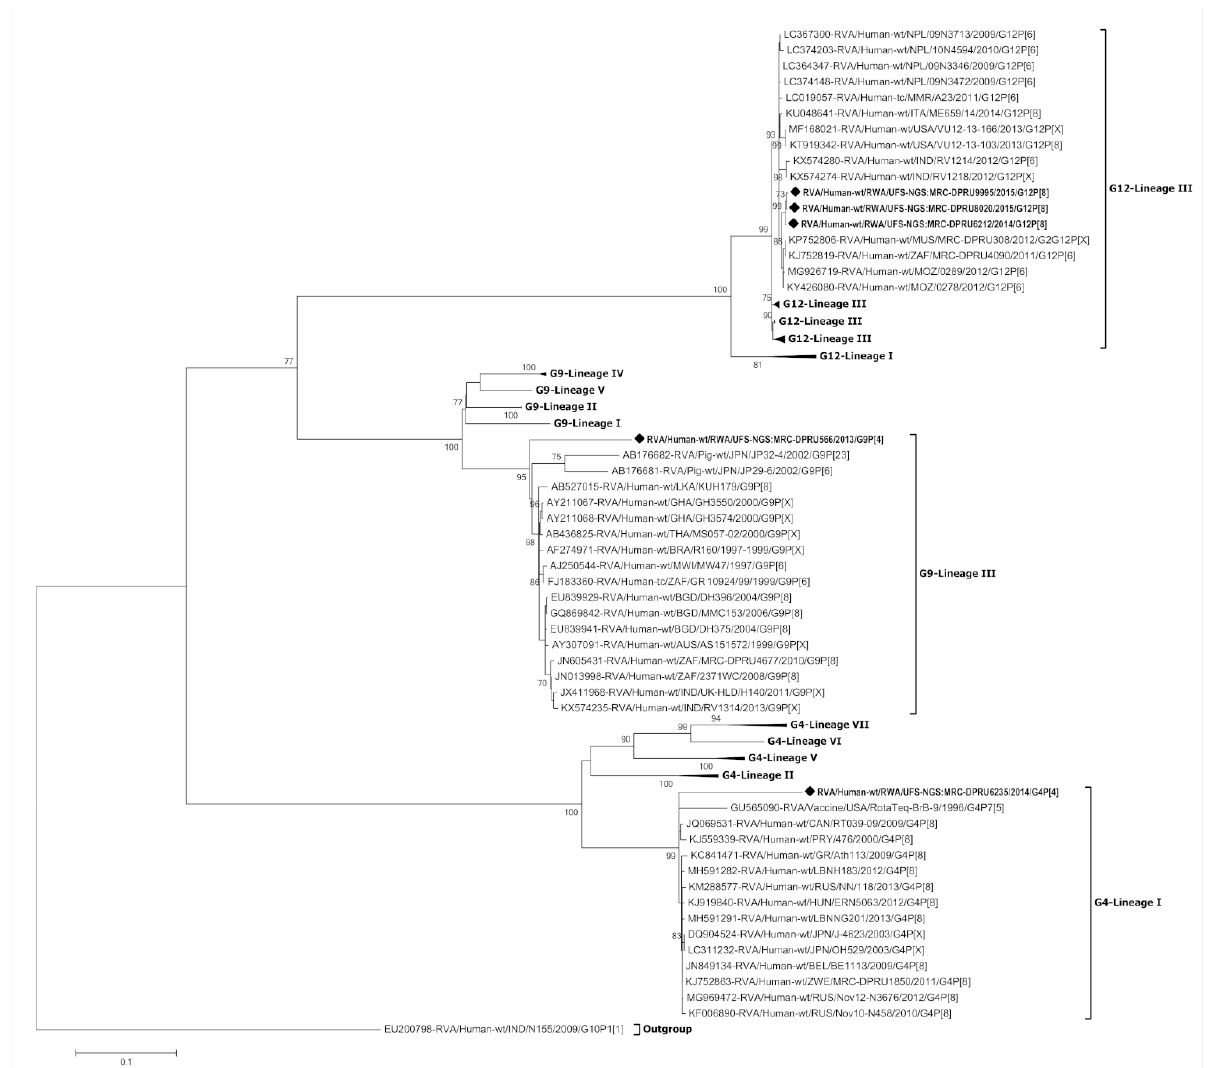
Figure 3. Phylogenetic relatedness of group A species based on VP7 of the study strains from Rwanda, G4, G9 and G12. The study strains are indicated with a black diamond. Bootstrap values ≥ 70% are indicated at each branch node. Scale bars represents substitutions per nucleotide